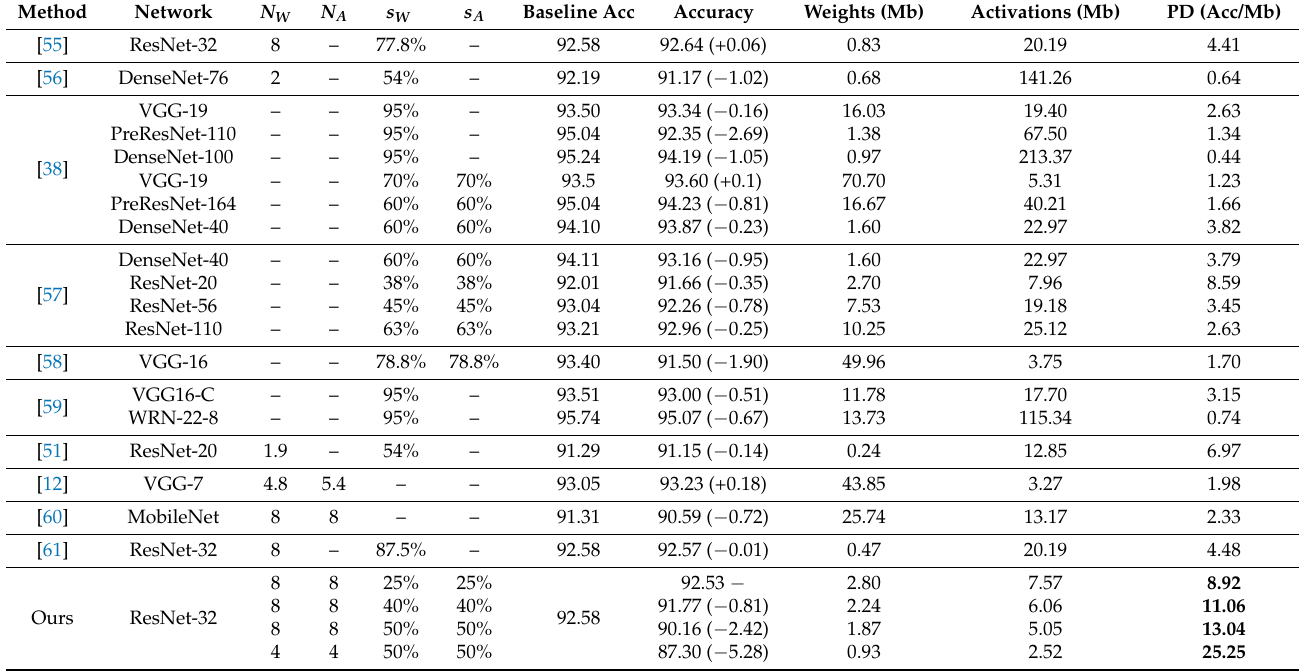
Table 4. We demonstrate the superior performance per memory footprint (i.e., performance density) of our framework when compared to existing image classification solutions trained on CIFAR10. By jointly applying uniform quantization and unstructured pruning to both the weights and activations of the DNN, we achieve a higher performance density (PD) with higher compression rates than existing solutions and comparable network performance.